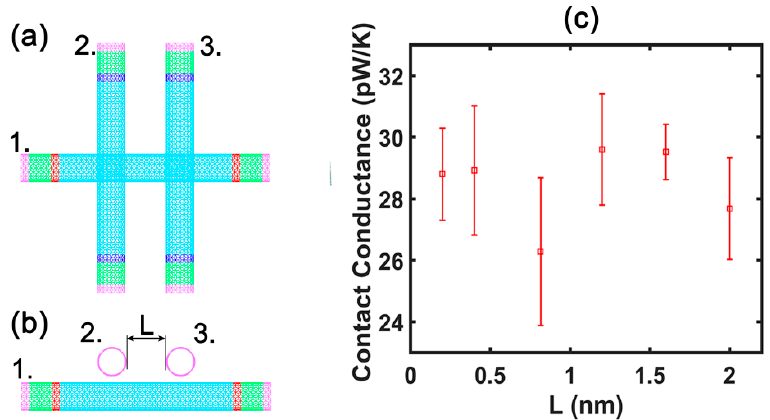
Figure 4. The calculation model 2 for the contact conductance of the double thermal contacts: ( a ) aerial view; ( b ) front view. ( c ) The variation of the contact conductance of the double thermal contacts with the distance between tubes 2 and 3.